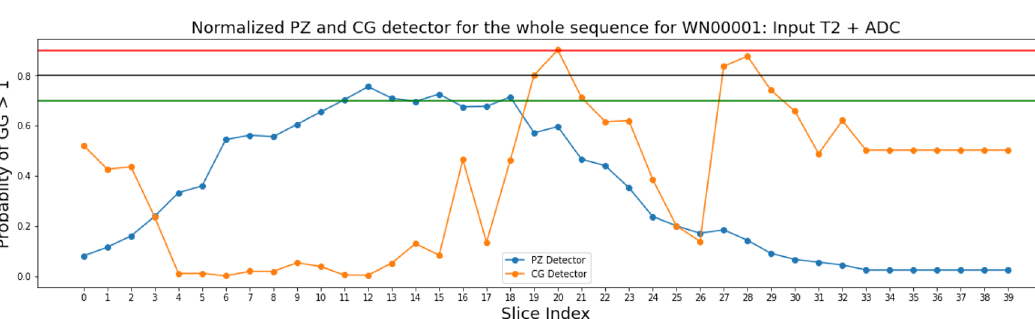
Figure 7. Predictions made on the sequence of Patient WN 00001 from the independent testing cohort by PZ-detector (blue) and CG-detector (orange), respectively. Horizontal lines with red, black and green color represent the cutoff of 0.9, 0.8 and 0.7 as the probability of a lesion being malignant.